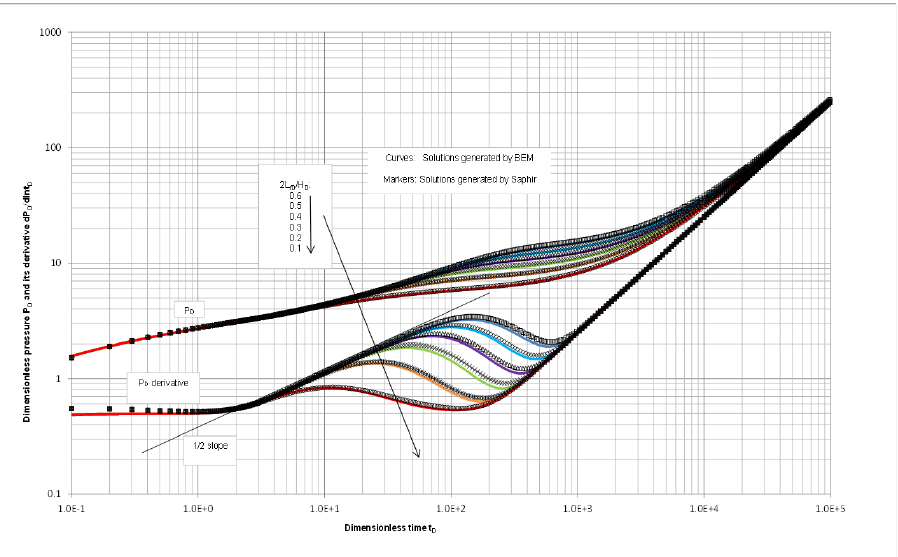
Figure 7. Pressure and its derivative behaviors of a well producing between two sealing faults in comparison to the solutions from Saphir for different 2 𝐻 𝐷 = 50 , 𝑤 𝑓𝐷 = 0.01 , and 𝑋 𝑣𝐷 = 5.